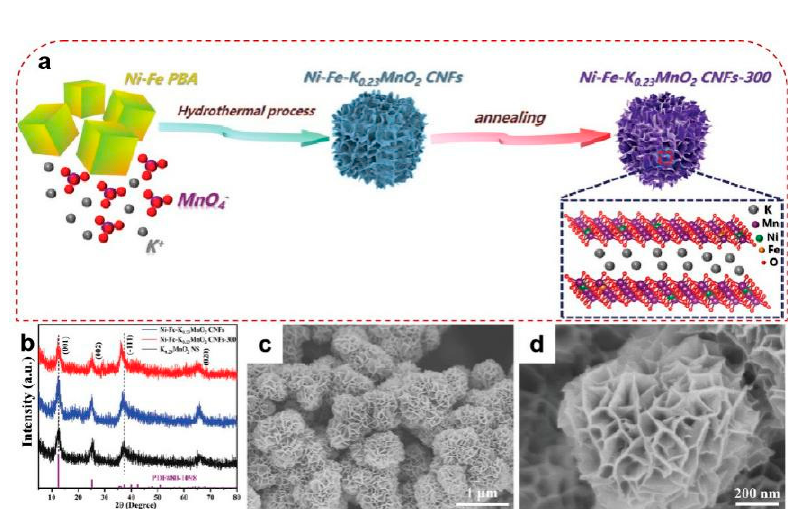
Figure 11. ( a ) Schematic diagram of the fabrication process for Ni-Fe-K 0.23 MnO 2 nanoflowers (Firstly, the Ni-Fe-PBA nanocubes were fabricated through the co-precipitation approach. Then the Ni-Fe-K 0.23 MnO 2 CNFs are formed by a hydrothermal reaction with the assistance of heating to 180 °C for 2 h. The further annealing process at 300 °C for 2 h in Ar atmosphere were aim to gain Ni-Fe-K 0.23 MnO 2 CNFs-300.); ( b ) XRD of the nanoflowers compared with the raw material K 0.23 MnO 2 nanosheets; and ( c , d ) FESEM images of the nanoflowers. Adapted with permission from [99]. Copyright © 2020 WILEY.